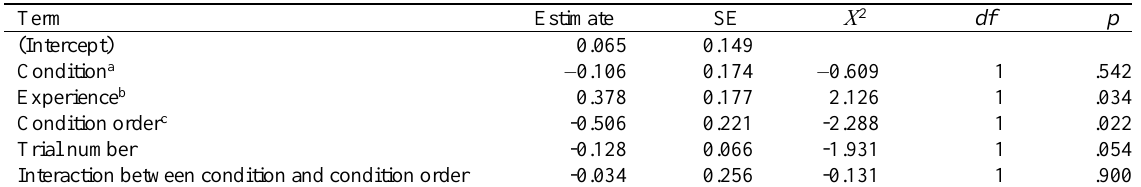
GLMM3: The Effect of Condition, Experience, and Condition Order on the Squirrel Monkeys Selecting the Correct Cup in Experiment 3